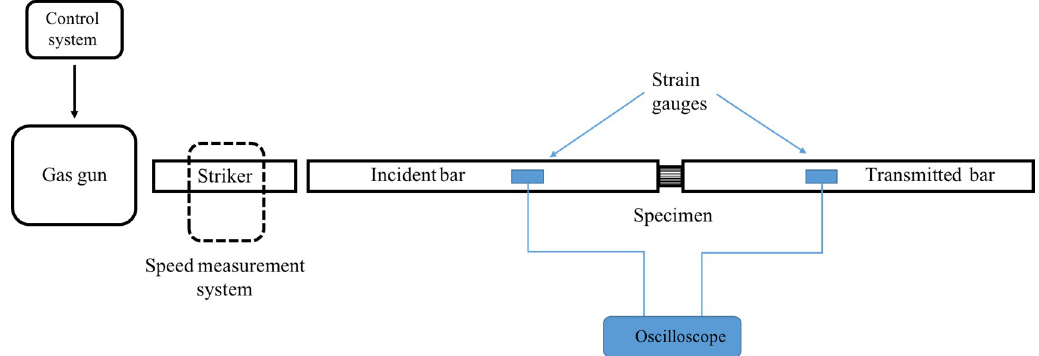
Figure 3. Schematic of the split Hopkinson pressure bar (SHPB) experimental system.